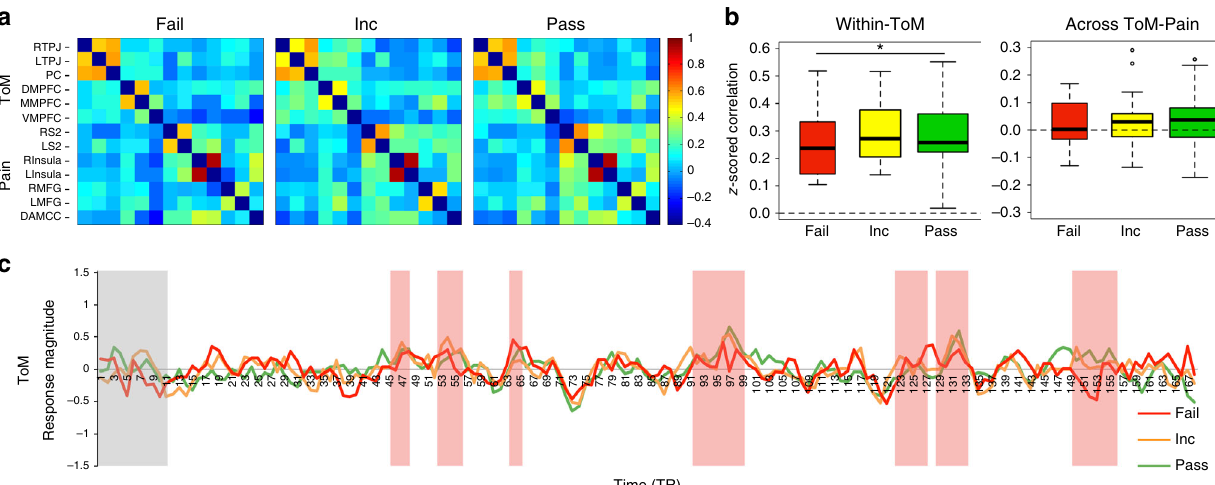
Fig. 3 Similar functional responses in children who pass and fail explicit false-belief tasks. a Average z -scored correlation matrices for three to 5-year-old children who pass ( n = 30), fail ( n = 15), or perform inconsistently on ( n = 20) explicit false-belief tasks. Regions are in the same order along the x -axes and y -axes. b Boxplots of z-scored correlation values within-ToM and across-ToM-Pain brain regions, based on false-belief task performance. Asterisk denotes a signi fi cant effect of false-belief task group (pass vs. fail) in a linear regression that also includes age and amount of motion (number of artifact timepoints) as covariates ( p < .05); this group effect becomes marginal when additionally including a measure of response inhibition (DCCS). c Average timecourse of response in the ToM network for false-belief passers (green), failers (red), and inconsistent performers (orange), during viewing of ‘